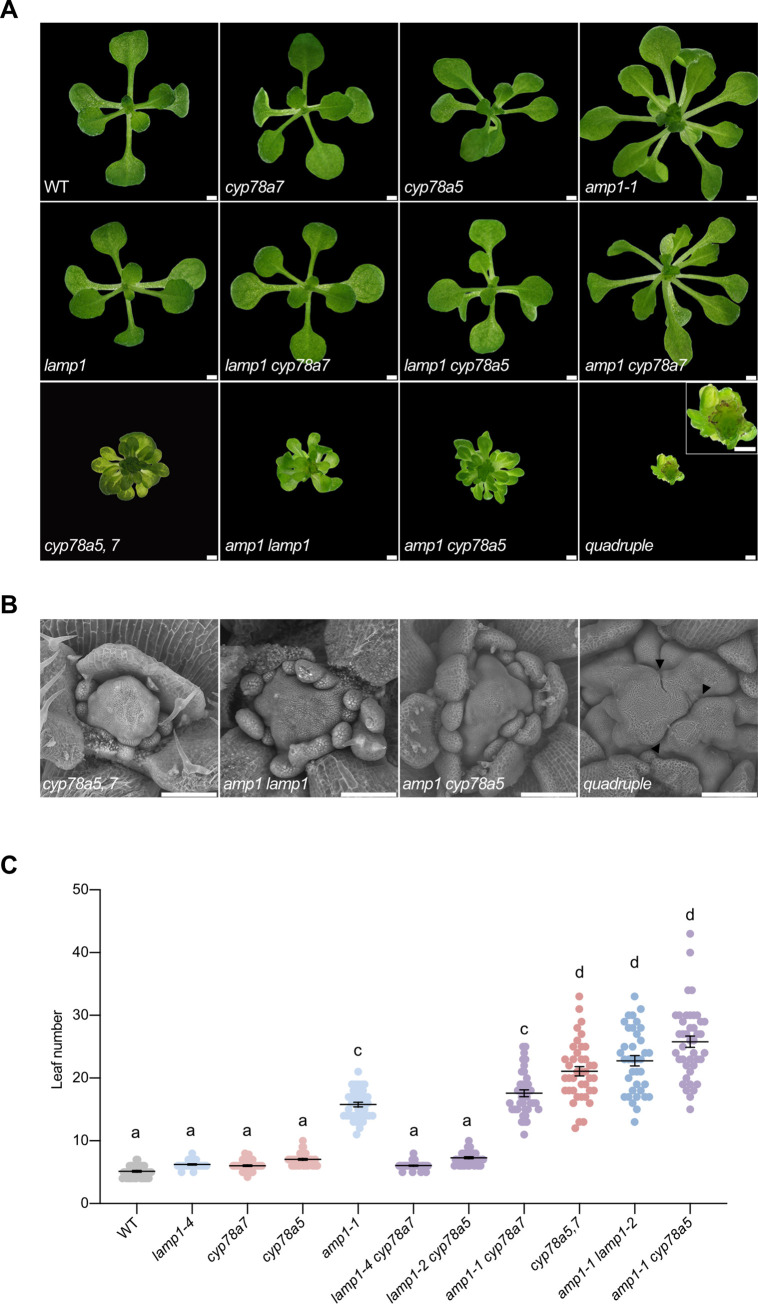
Seedling phenotypes of amp1, lamp1, cyp78a5 and cyp78a7 mutant combinations.(A) Shoot phenotypes of indicated genotypes at 14 DAG (except for the quadruple mutant, which was pictured at 12 DAG). A close-up of the quadruple mutant is presented in the upper right corner. (B) Scanning electron micrographs from shoot apices of the indicated genotypes at 7 DAG. In cyp78a5,7 and amp1 lamp1 some of the leaf primordia were removed for better visibility of the meristem structure. Arrowheads mark the callus-like invaginations in the quadruple mutant. (C) Quantification of rosette leaf number in the indicated genotypes at 10 DAG (means ± SE of the mean; n ≥ 35). Different letters over the error bars indicate significant differences (P < 0.05; one-way ANOVA followed by Tukey’s multiple comparison tests). Size bars represent 1 mm (A) and 250 μm (B).